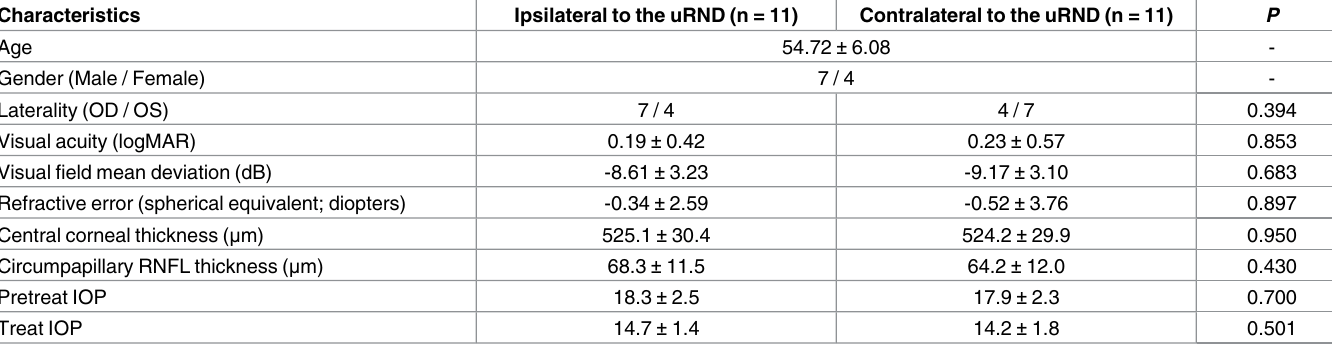
Table 1. Baseline characteristics of POAG eyes ipsilateral to the uRND and in POAG eyes contralateral to the uRND. Characteristics